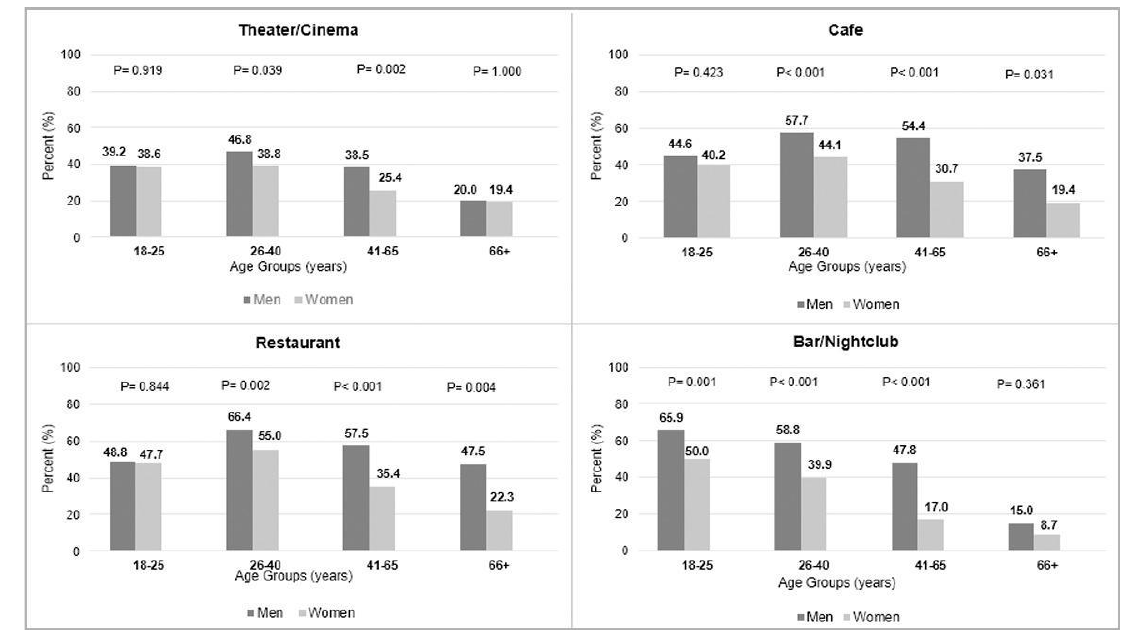
Figure 4. Frequency of the recreational activities between men and women in each age group ( p, p-value ).